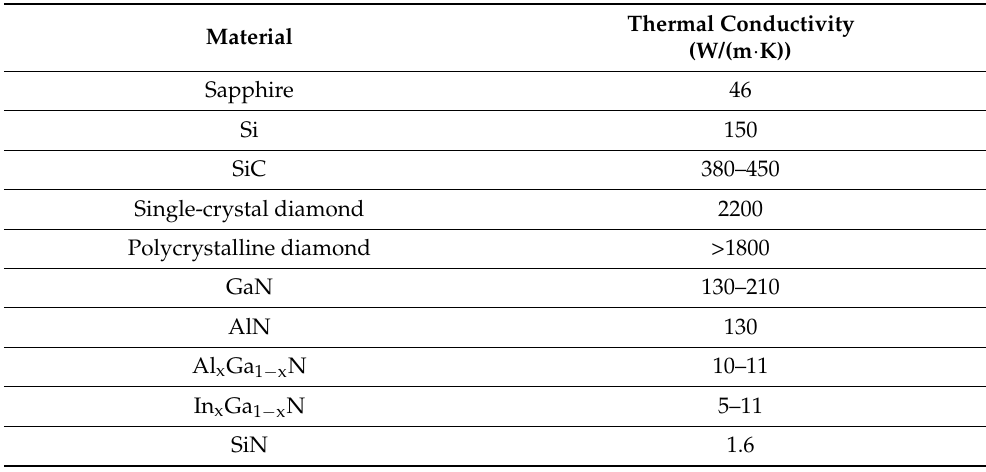
Table 2. Typical thermal conductivity of the materials present in an AlGaN/GaN HEMT